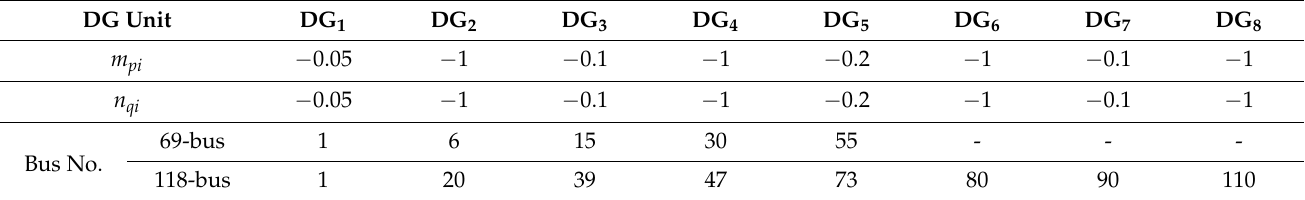
Table 2. DG units’ droop coefficients for the No DL